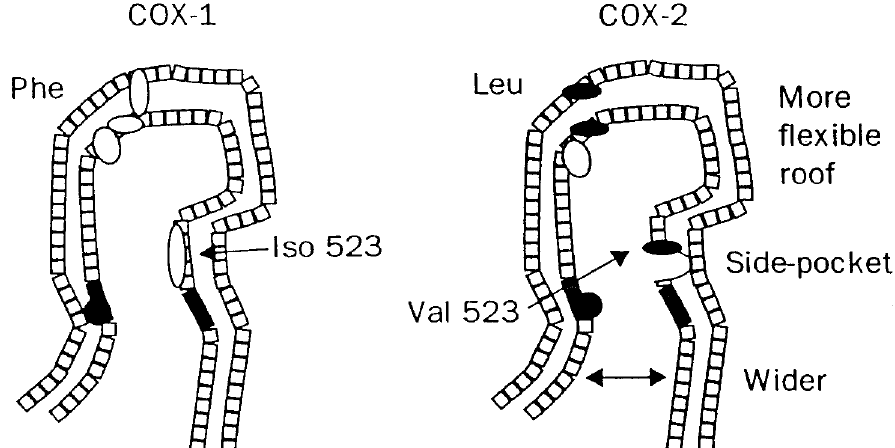
FIG. 1. Differences between the cyclooxygenase active sites of COX-1 and COX-2. The isoleucine at position 523 (Iso 523) in COX-1 is replaced by a valine in COX-2. This substitution creates a side pocket of the active binding site of COX-2, not present in COX-1, and a somewhat wider binding site in